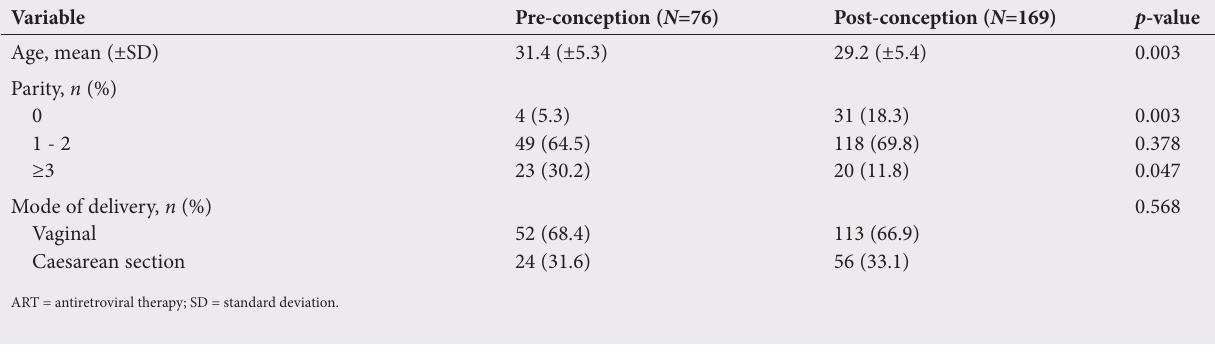
Table 2. Comparison of gestational age and birth weight between the pre- and post-conception ART groups